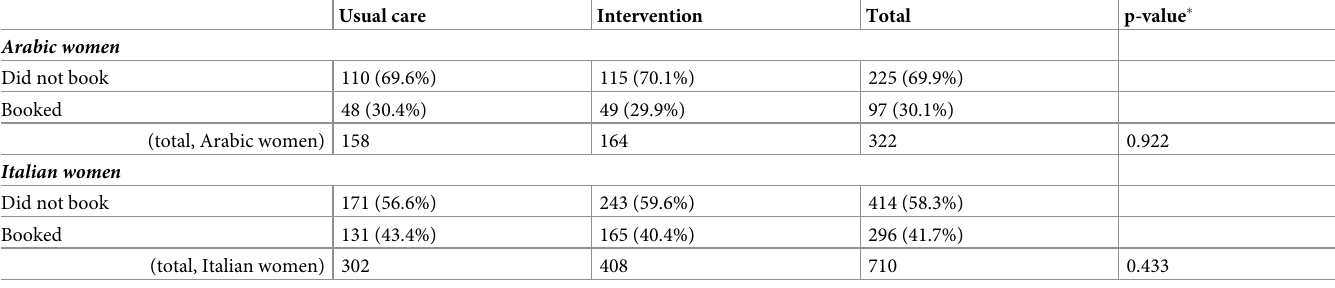
Table 2. Frequency and proportion of booking a screening appointment within 14 days in the letters trial by language group.